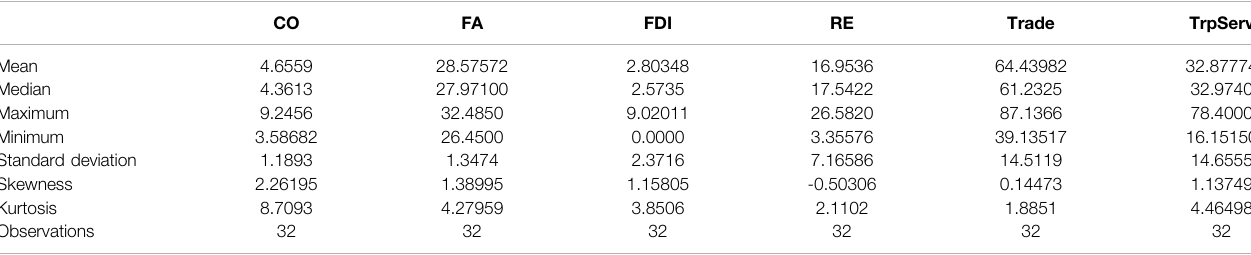
TABLE 2 | Descriptive statistics.